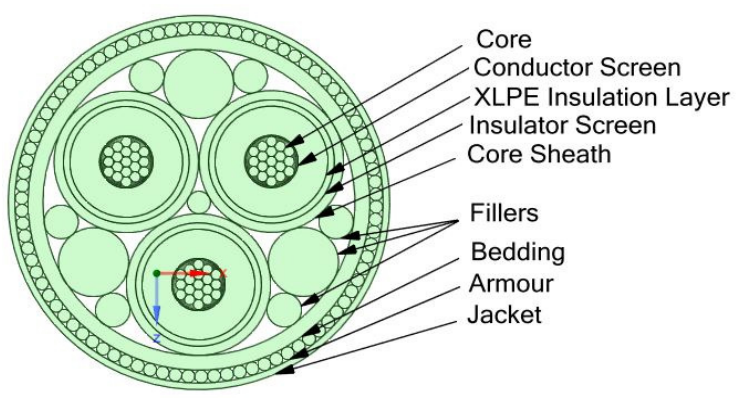
Figure 2. Cross-section of the cable [1].